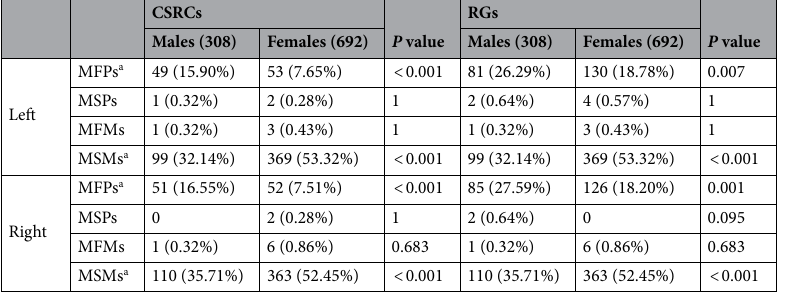
Table 2. Distribution of CSRCs and RGs in different tooth positions and sex. CSRCs: C-shaped root canals, RGs: radicular grooves, MFPs: mandibular first premolars, MSPs: mandibular second premolars, MFMs: mandibular first molars, MSMs: mandibular second molars. a The prevalence of CSRCs in MFPs of males was higher than that in females, while the prevalence of CSRCs in MSMs of females was higher than that in males.